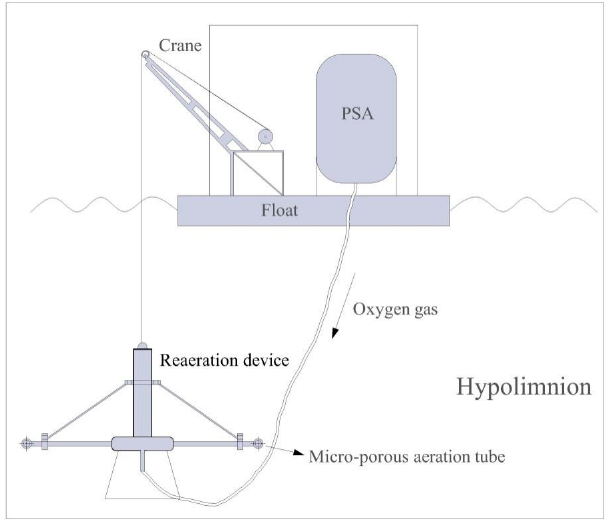
Figure 2. Sketch map of the reaeration